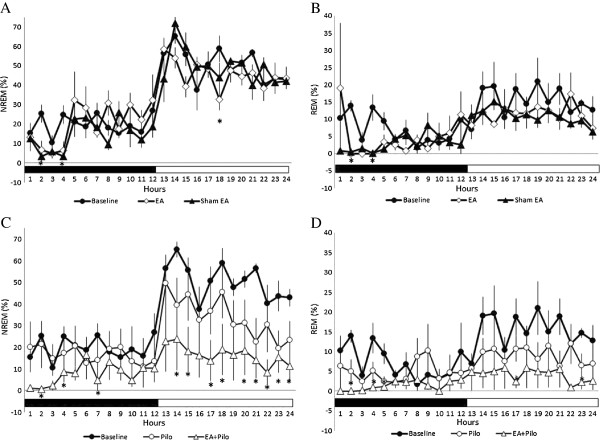
The effects of 100 Hz EA stimulation and pilocarpine in sleep. Panels A &B: NREM sleep and REM sleep obtained from the undisturbed baseline, shame EA group and EA group. Panel C &D: NREM sleep and REM sleep acquired from the baseline, the pilocarpine group and the PFS + EA + pilocarpine group. Black circles: the values obtained from undisturbed rats (baseline); black triangles: the values obtained from the sham EA group; open diamonds: the values acquired from the EA group; open circles: the values obtained from the pilocarpine group; open triangles: the data acquired from the PFS + EA + pilocarpine group. *: p < 0.05 vs. baseline. Black bar: the dark period; white bar: the light period.